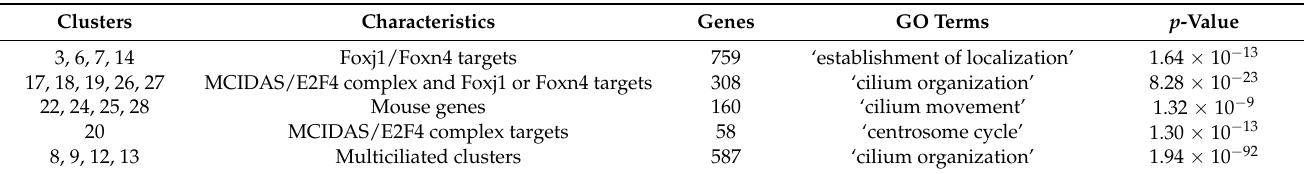
Table 2. Cluster regrouping according to similarity in profiles. Pertinent GO terms were selected among the ‘biological process’ GO annotation dataset and the results with the lowest p